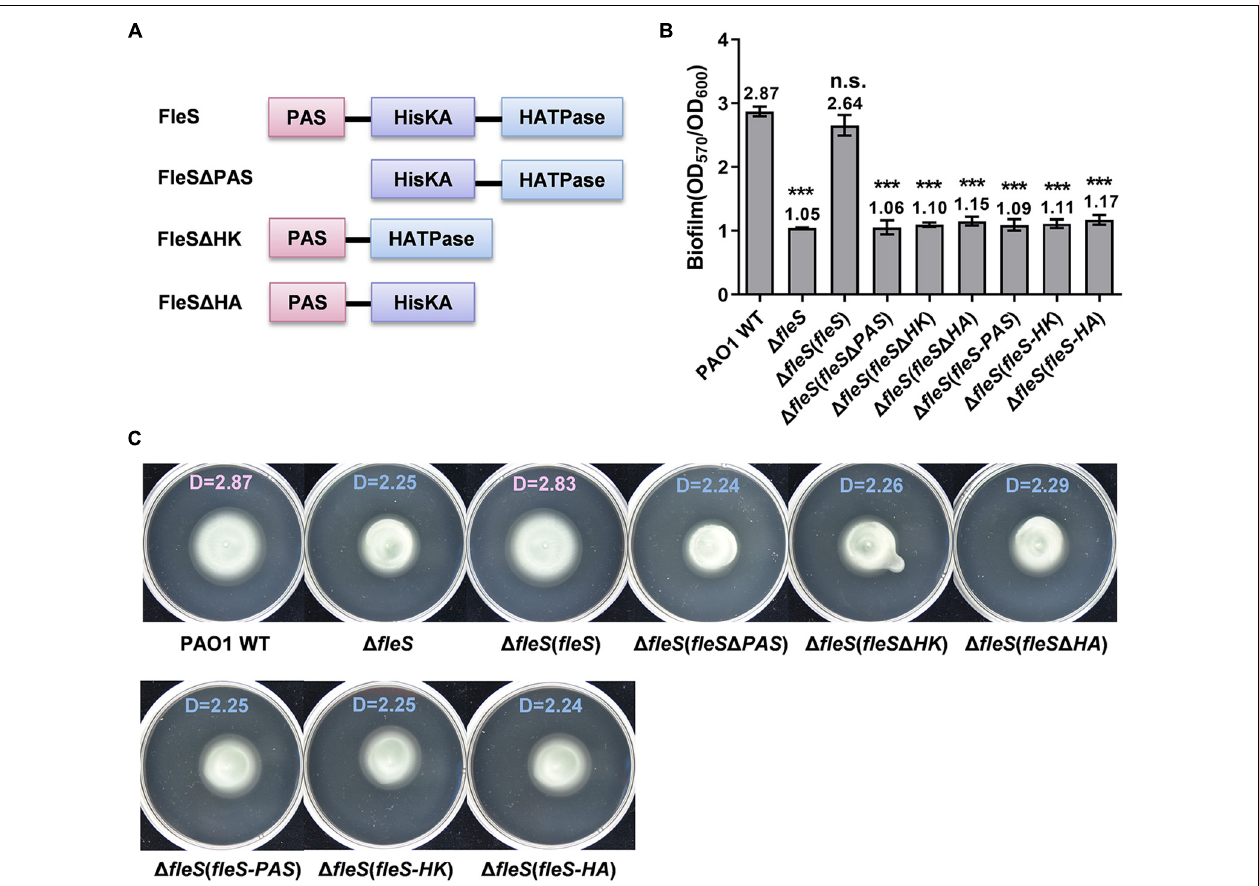
FIGURE 1 | PAS, HisKA, and HATPase domains in FleS are all essential for its signaling to regulate biofilm formation and swimming motility. (A) A schematic diagram showing the domain structures of FleS and its variants. Domain structures were predicted using the SMART program (http://smart.embl-heidelberg.de/). (B) Biofilm formation of the PAO1 wild type (WT), the ? fleS mutant and the ? fleS mutant with ectopic expression of FleS, FleS (cid:49) PAS, FleS (cid:49) HK, FleS (cid:49) HA as well as the single FleS domains FleS-PAS, FleS-HK, and FleS-HA. The result is shown as the mean of five replicates per strain and error bar indicates the standard error of mean (SEM). *** P < 0.001, n.s., no significance (Student’s t -test). (C) Swimming motility of the PAO1 wild type, the (cid:49) fleS mutant and the (cid:49) fleS mutant with ectopic expression of FleS, FleS (cid:49) PAS, FleS (cid:49) HK, FleS (cid:49) HA, FleS-PAS, FleS-HK, and FleS-HA. Representative images and the average diameter (D) of the swimming migration zone of each strain are shown. Each experiment was performed in